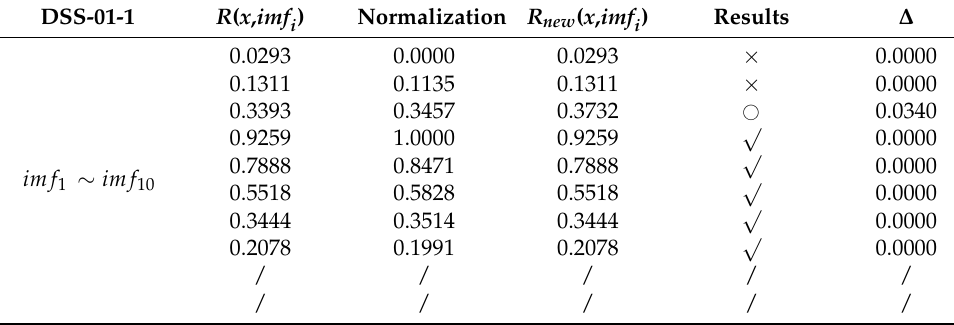
Table 7. The correlation coefficient of DSS-01-1.